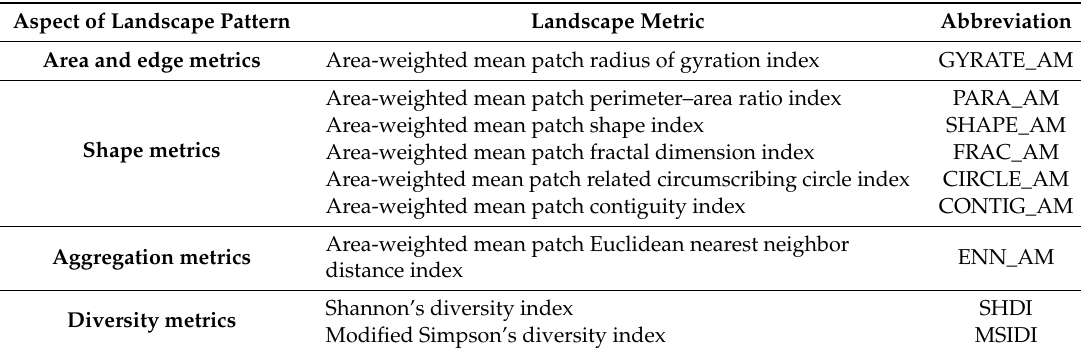
Table 2. The selected landscape metrics in the urban land-use classification.